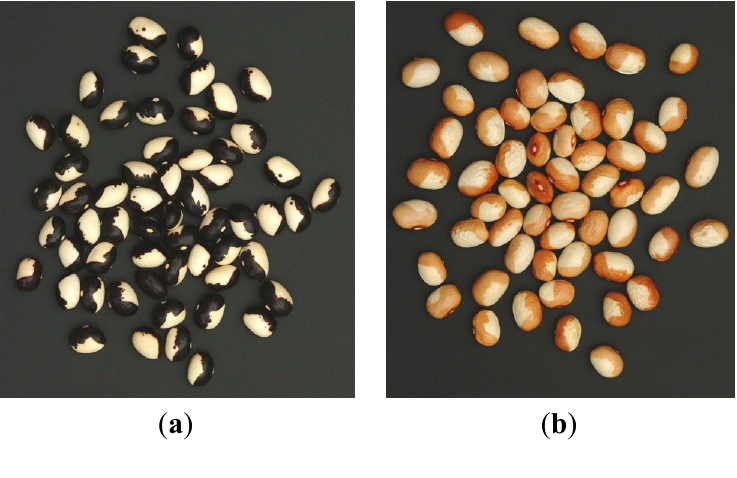
Figure 2. Seeds of ( a ) the “Badda nero” and ( b ) the “Badda bianco” common